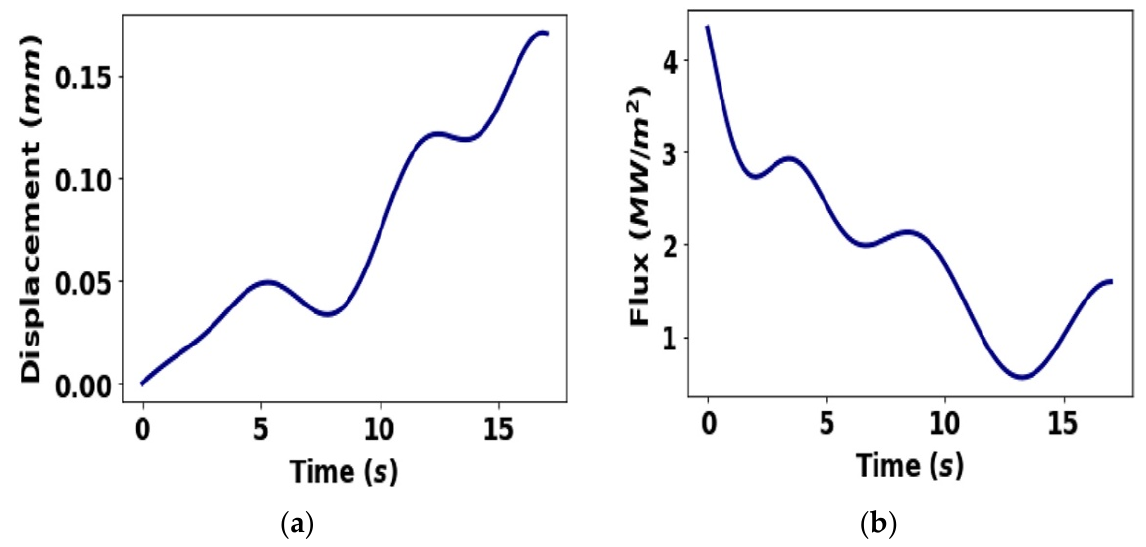
Figure 7. Example of a testing input data sample: ( a ) displacement profile and ( b ) flux profile.